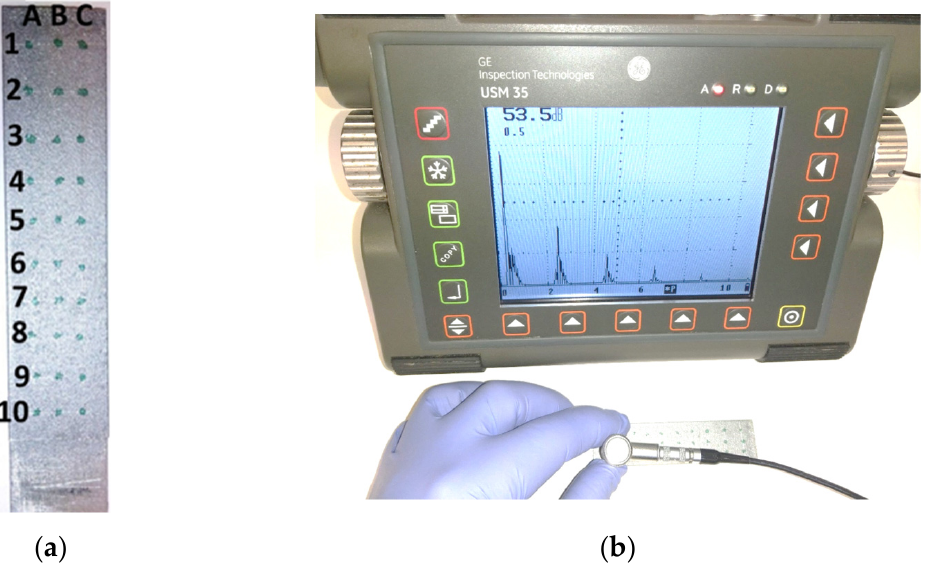
Figure 4. Testing the homogeneity of acoustic parameters of a sample made with additive manufacturing technology; ( a ) view of the sample with the measurement grid, ( b ) view of the test stand.